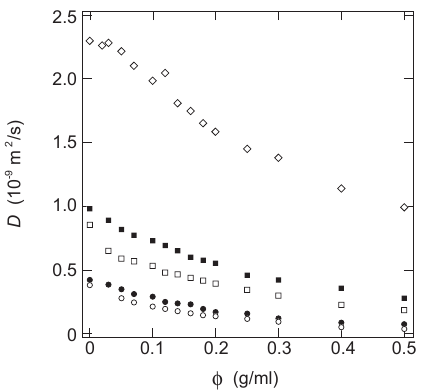
Figure 1. The dependence of the diffusion coefficient of probe molecules on the concentration of acrylamide (AAm) in gel. The probe molecules are water, diamonds, ethanol (filled squares), glycerin (open squares), poly(ethylene glycol) (filled circles), and sucrose (open circles), from top to bottom. The data points at the position of zero concentration represent the diffusion coefficient of each probe moleculesinwaterthataremeasuredbythesameexperimentalsetup. Thetemperatureisfixedat30.0 ± 0.5 ◦